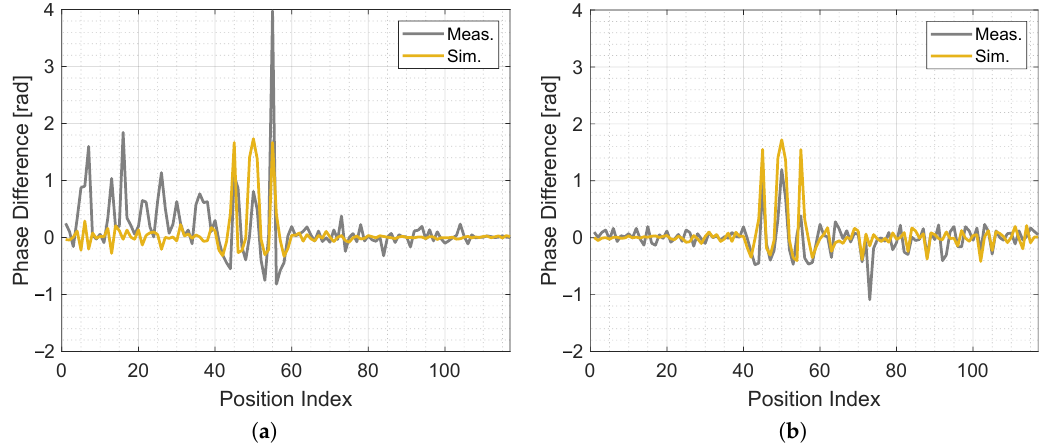
Figure 13. Measured and simulated phase differences. ( a ) Simulated and measured ∆ φ 1 . ( b ) Simulated and measured ∆ φ 2